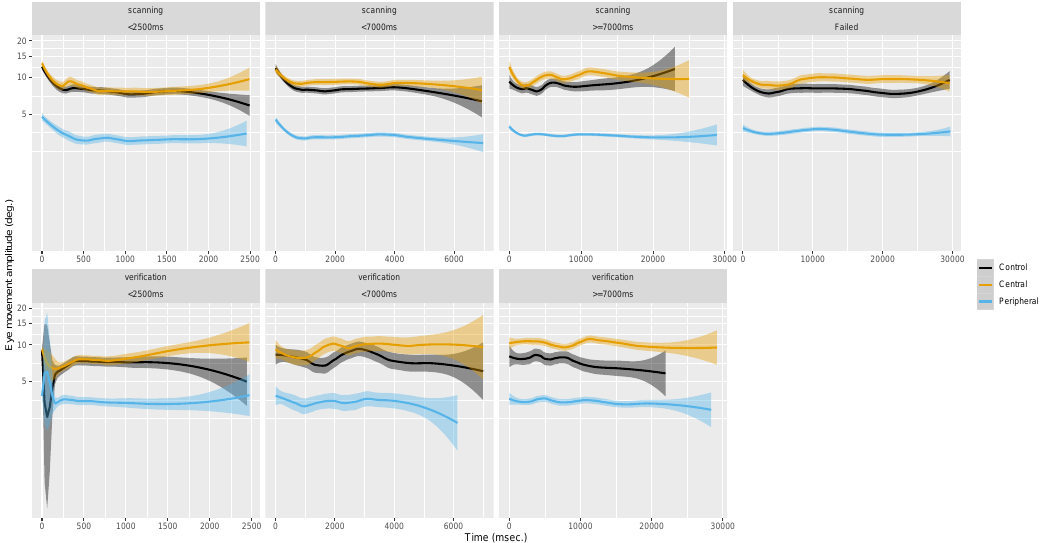
Figure A7. Time-course of average eye movements amplitude during saccades as a function of search phase (trial duration subgroups do not overlap). Ribbons show 95%CI. Control condition appears in black, central in orange and peripheral in blue.